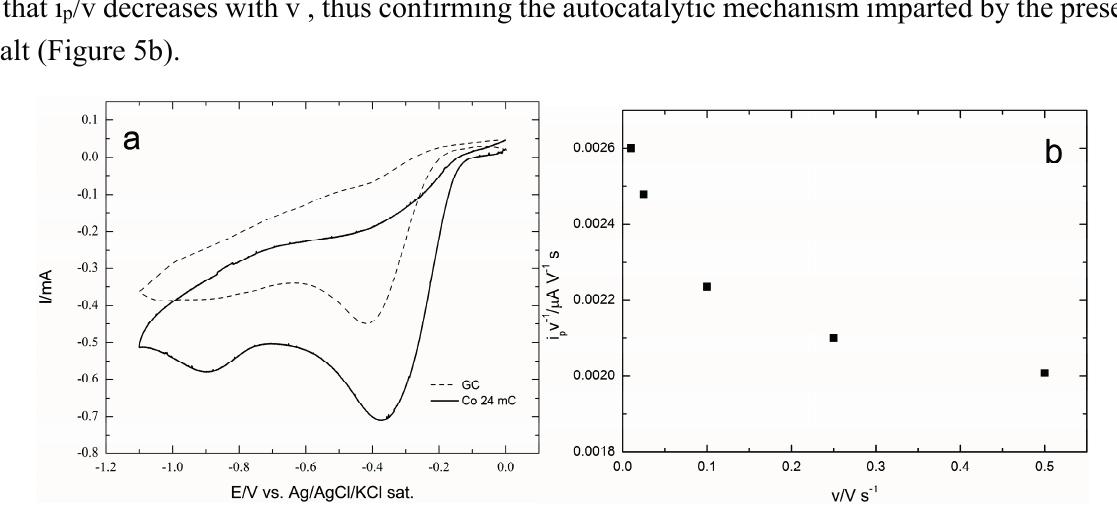
Figure 5. ( a ) Cyclic voltammograms recorded at GC (dashed curve) and at GC/Co(OH) 2 (solid lines) stationary electrodes; ( b ) i p /v ratio as a function of the scan rate